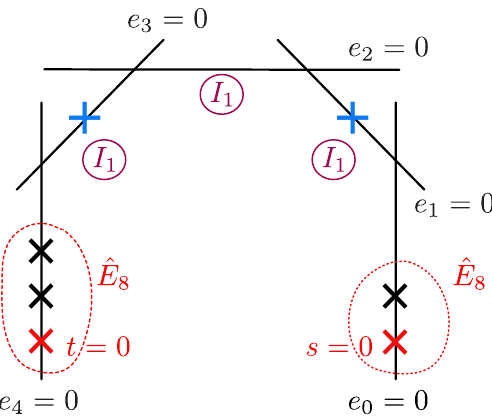
Figure 7 . Kulikov Type III degeneration of E 7 × E 8 Weierstrass model (4.34) for generic values of the parameters b and x 1